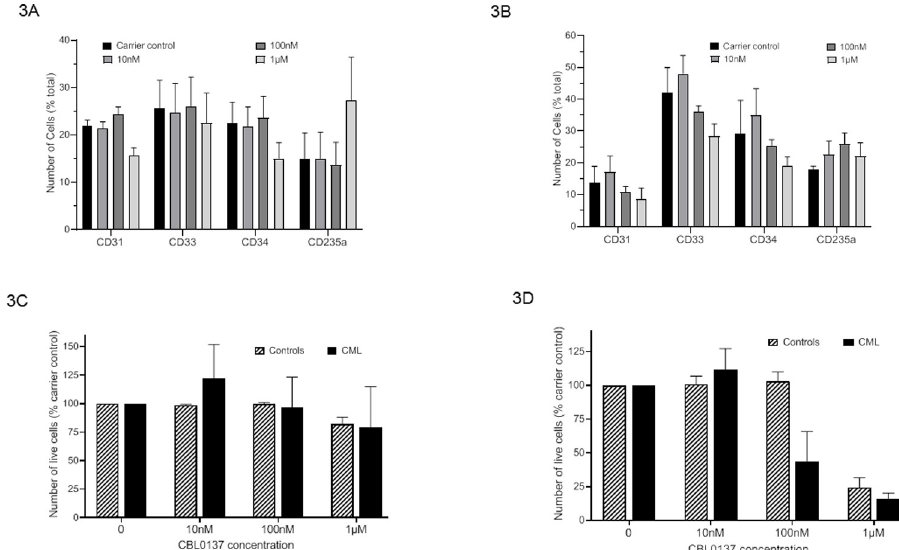
Fig 3. CBL0137 has distinct effects upon different myeloid cell populations in cells from healthy controls and CML patients. CD34+ cells isolated from CML patients and healthy controls were cultured in IMDM, 20%(v/v) fetal calf serum, rhIL-3 (20ng/ml), rhGM-CSF (10ng/ml), rhSCF (50ng/ml) and Epo (2u/ml) for 72hrs in the presence of 0, 10nM, 100nM or 1 μ M CBL0137. Cells were stained with cell surface marker antibodies shown prior to staining with Annexin V and Hoechst 33258. Fluorescence was measured on an LSR II (Becton Dickinson) and results analysed using FloJo software. The results are displayed as the number of cells in each myeloid cell population as a percentage of the total cell population for healthy controls (Fig 3A) and CML (Fig 3B) and as the number of live cells (as a percentage of the carrier control) in the whole population (Fig 3C) or the CD34+ population (Fig 3D). Results shown are mean ± SEM n = 3 for CML and n = 4 for